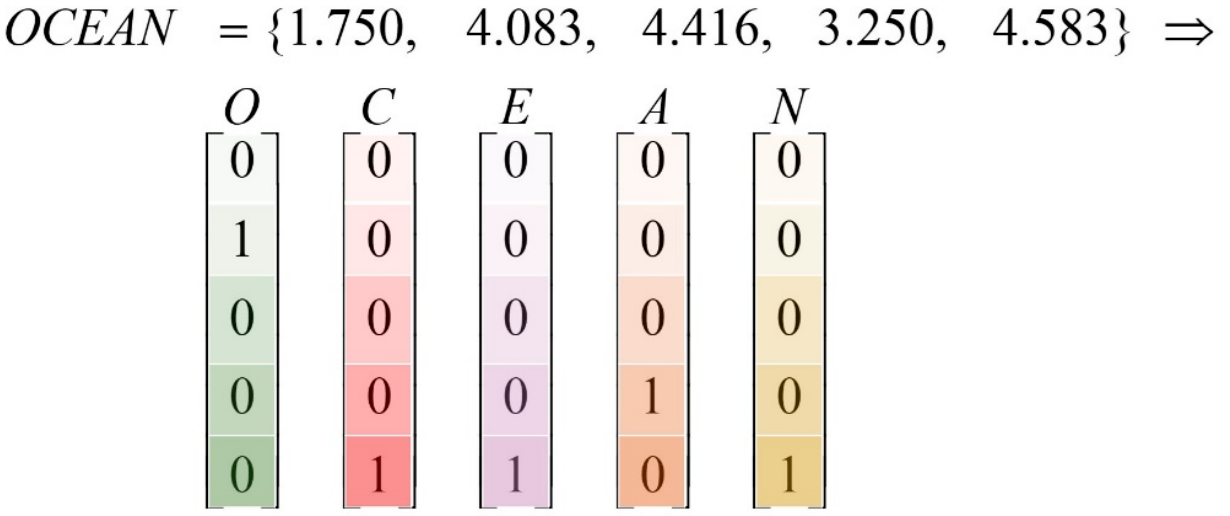
Figure 5. Schematic diagram of multi-category output. The letters O, C, E, A, and N represent “Openness, Conscientiousness, Extraversion, Agreeableness, and Neuroticism”, respectively. In other words, there are five multi-classifiers in the prediction experiment of the OCEAN personality model. For example, the results of sample inputs and outputs for the openness (openness) dimension of the OCEAN personality model can be expressed as Figure 6.